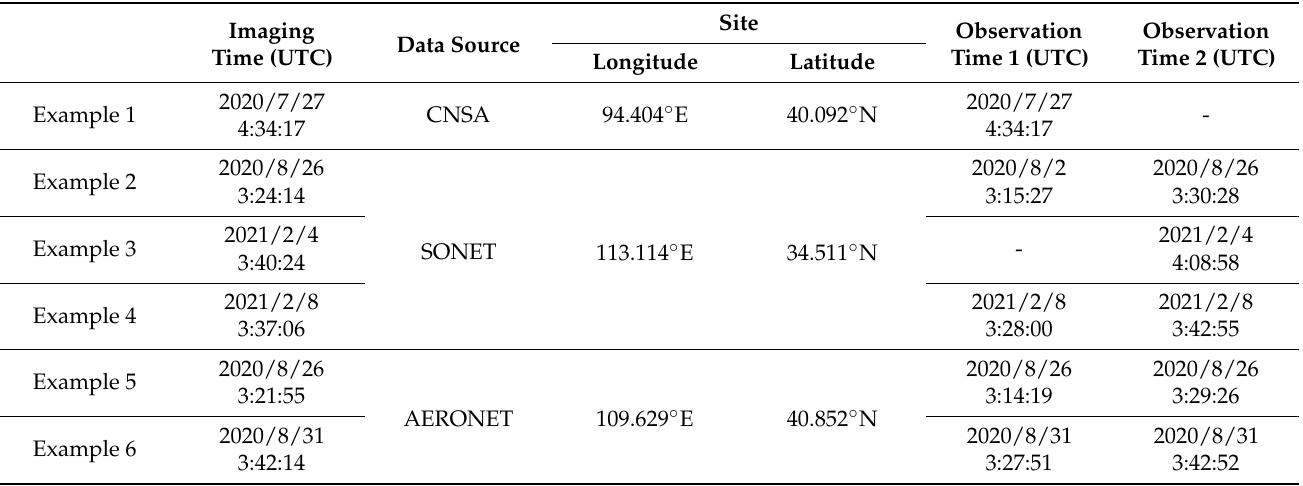
Table 6. Ground-based sites and